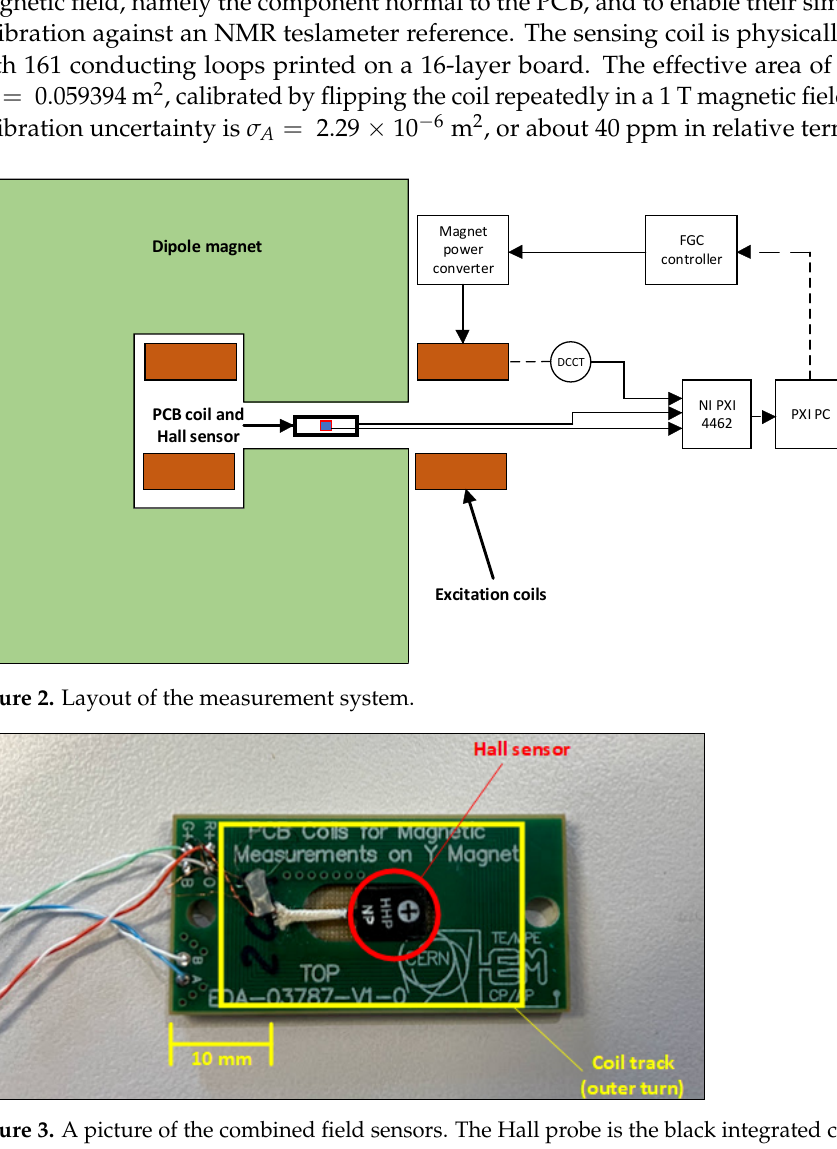
Figure 3. A picture of the combined field sensors. The Hall probe is the black integrated circuit at the center of the